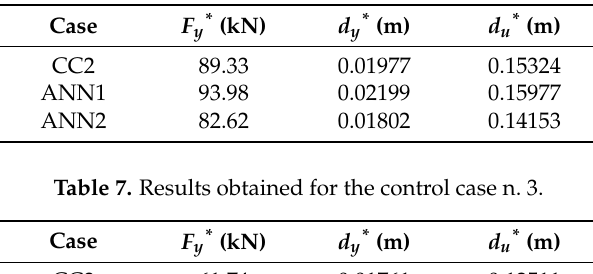
Table 6. Results obtained for the control case n. 2.